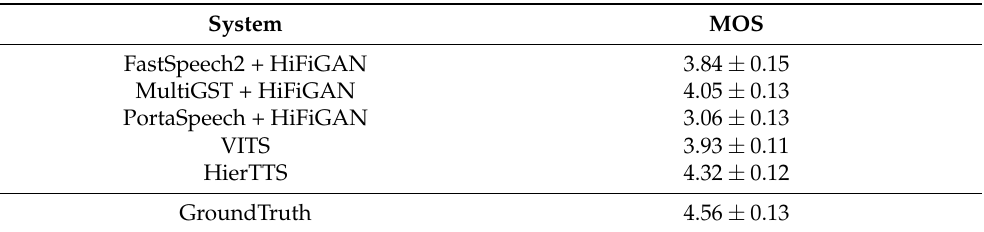
Table 1. MOS evaluation of HierTTS and baselines with 95% confidence